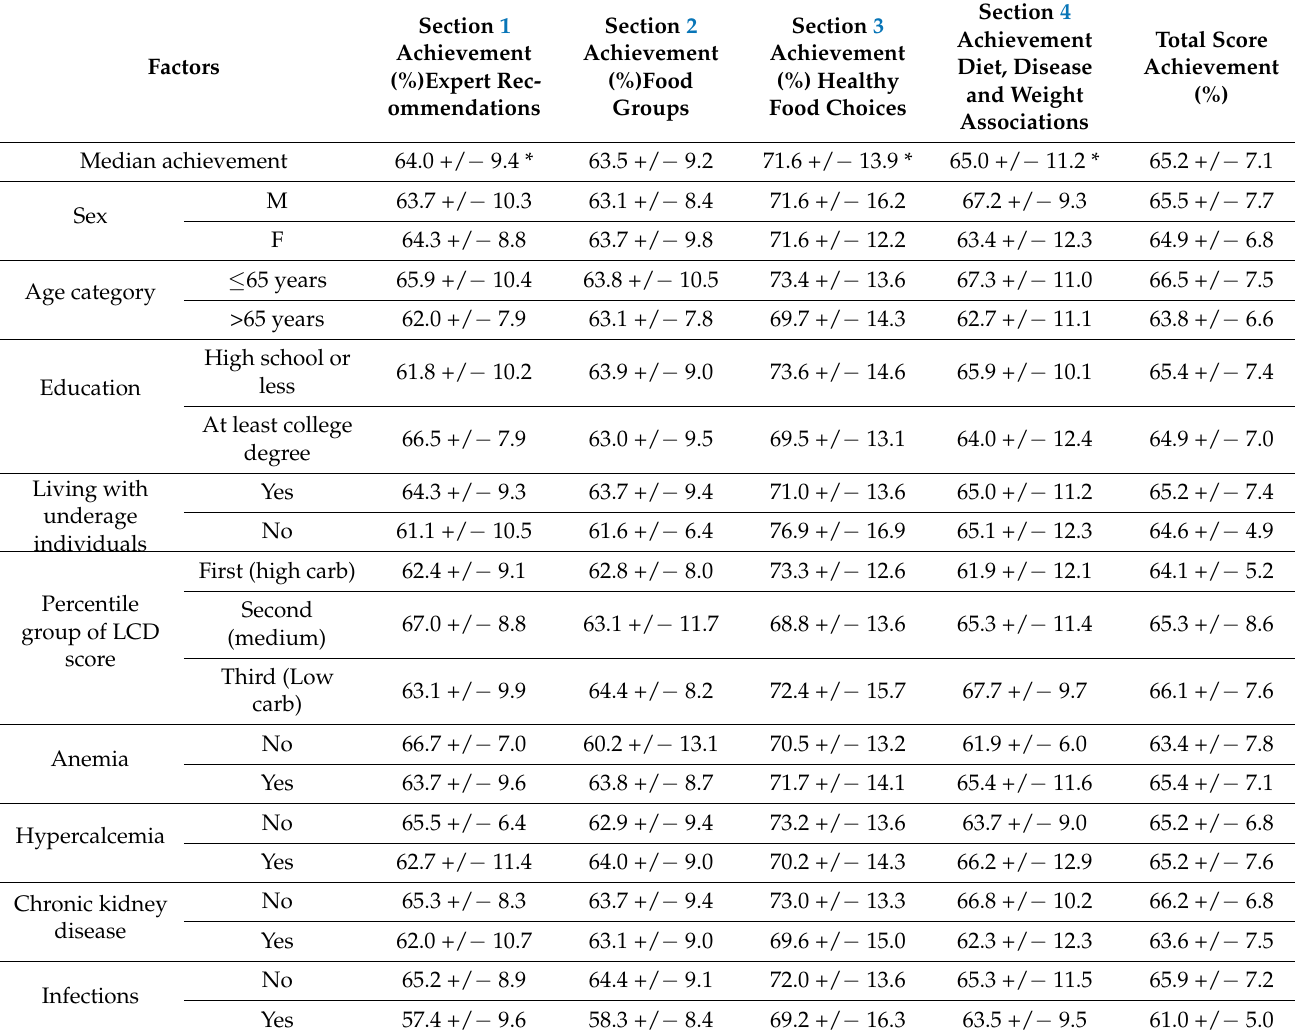
Table 4. Nutrition knowledge score percentages per sections and total score (N = 61